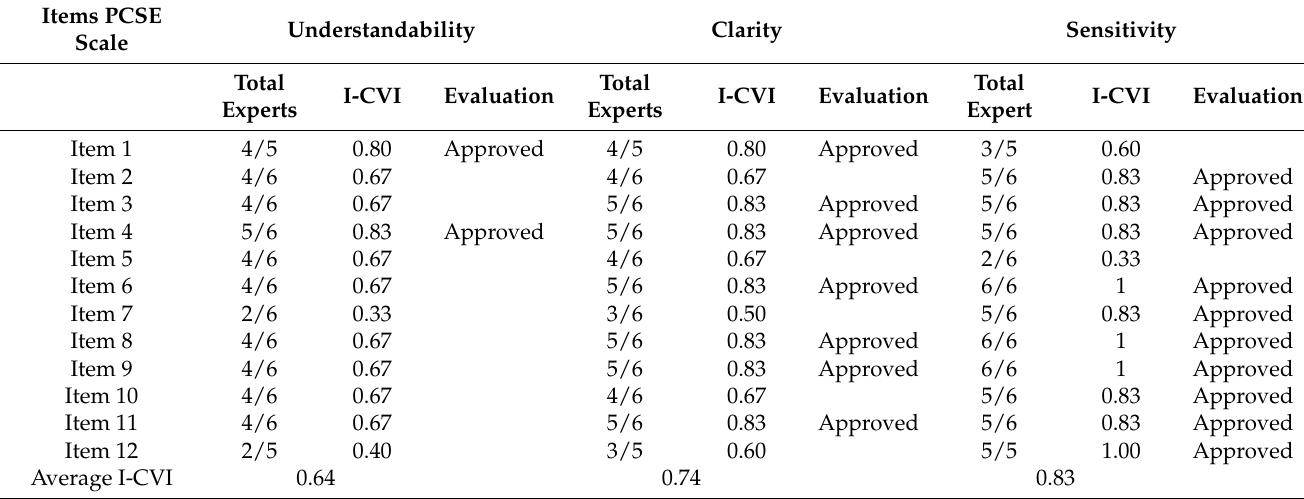
Table 3. The understandability, clarity, and sensitivity of items on the PCSE scale; dichotomized into 1–3 = 0 and 4–5 = 1.